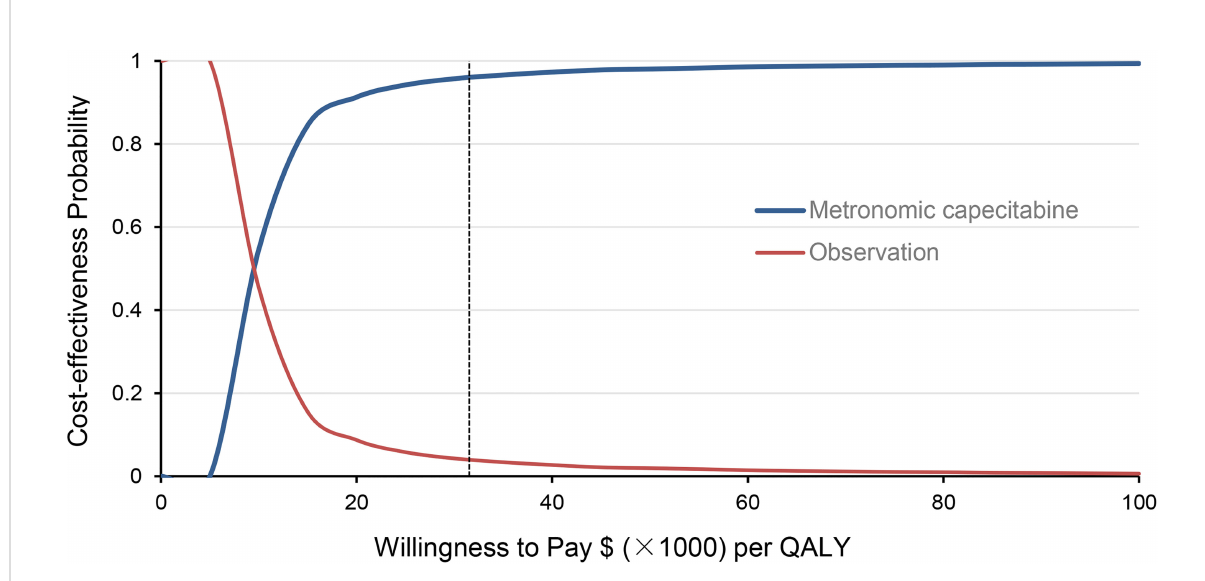
FIGURE 3 Acceptability curves of cost-effectiveness probability for metronomic capecitabine and observation treatment at different willingness-to-pay (WTP) values in locoregionally advanced nasopharyngeal carcinoma